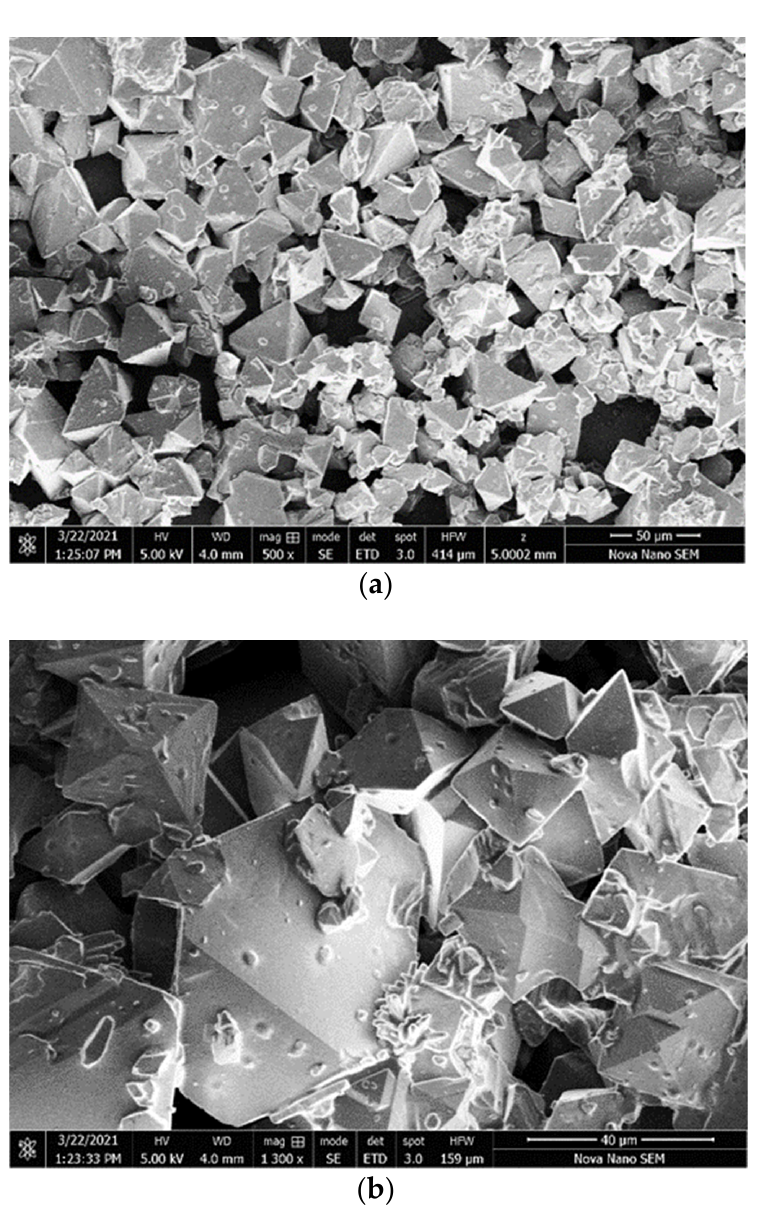
Figure 6. FESEM micrographs (surface view) of TPPNi active humidity sensing layer at ( a ) 500 and ( b ) 1.3k magnification scales. ( b ) 1.3k magnification